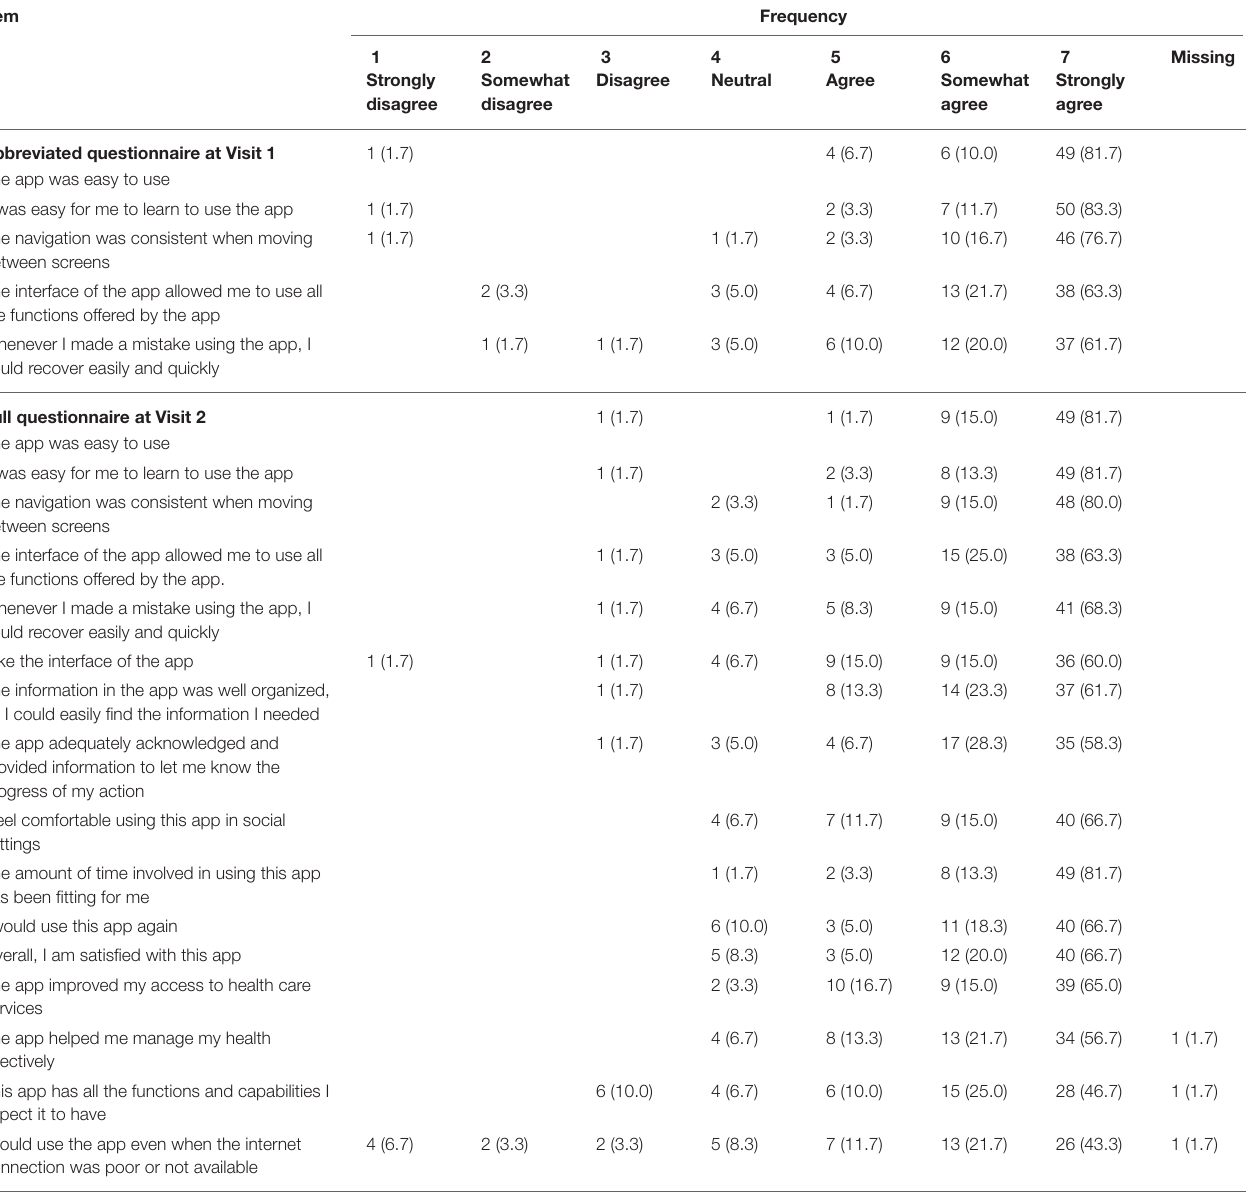
TABLE 3 | Summary of the user experience in the multicenter clinical trial.